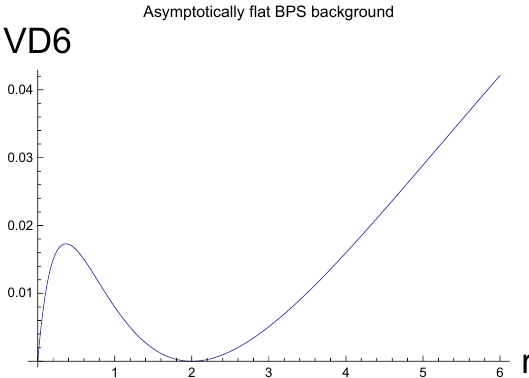
Figure 11 . BPS potential for D6 probes in asymptotically flat space: there is a minimum of the potential, V = 0 outside the horizon at the value x worldvolume flux f = 1 and the asymptotic values of the scalars are set to one). The value of x obtained from the probe potential agrees with the value of the exact two center solutions of